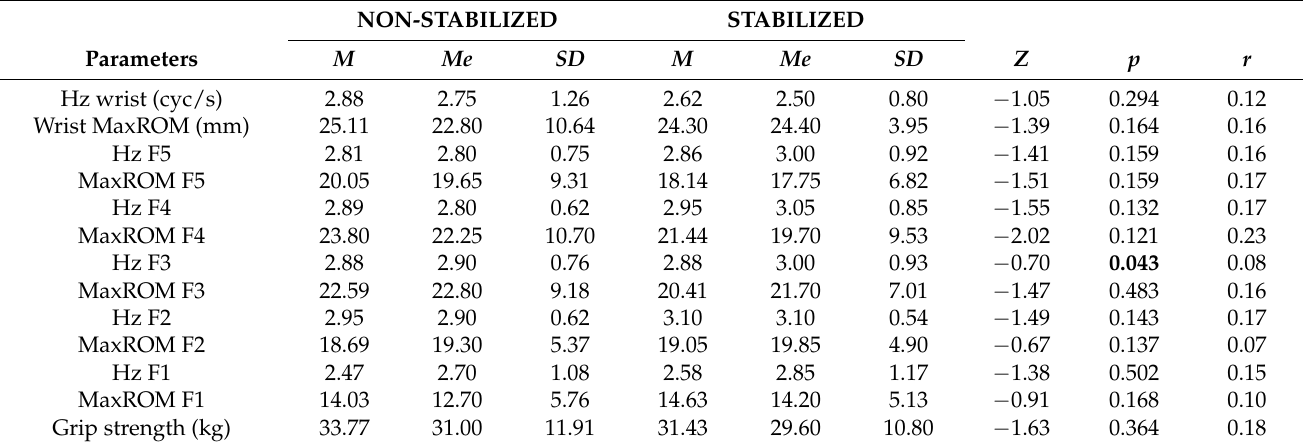
Table 10. Comparison of the results of parameters in the stabilized and stabilized position for the age group of 61 and more healthy